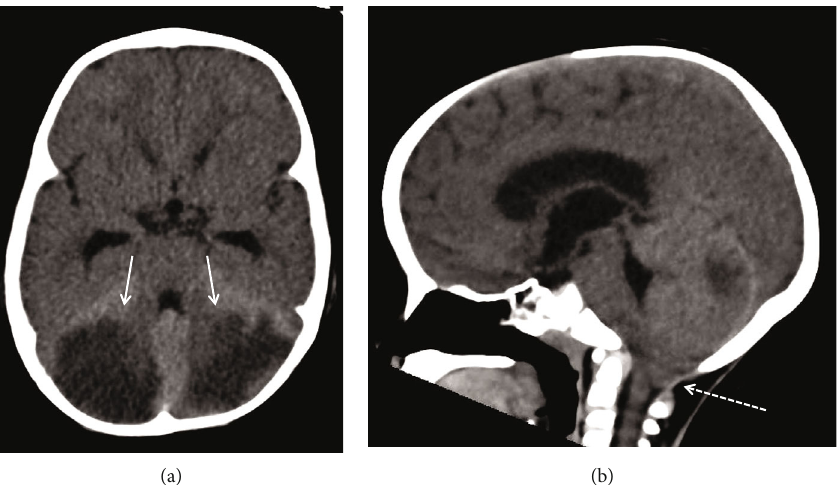
Figure 1: Axial (a) and midsagittal (b) noncontrast head CT at presentation shows bilateral cerebellar hemisphere hypoattenuation (low density) with swelling (arrows). There is inferior herniation of the cerebellar tonsils with crowding at the foramen magnum (dashed arrow).